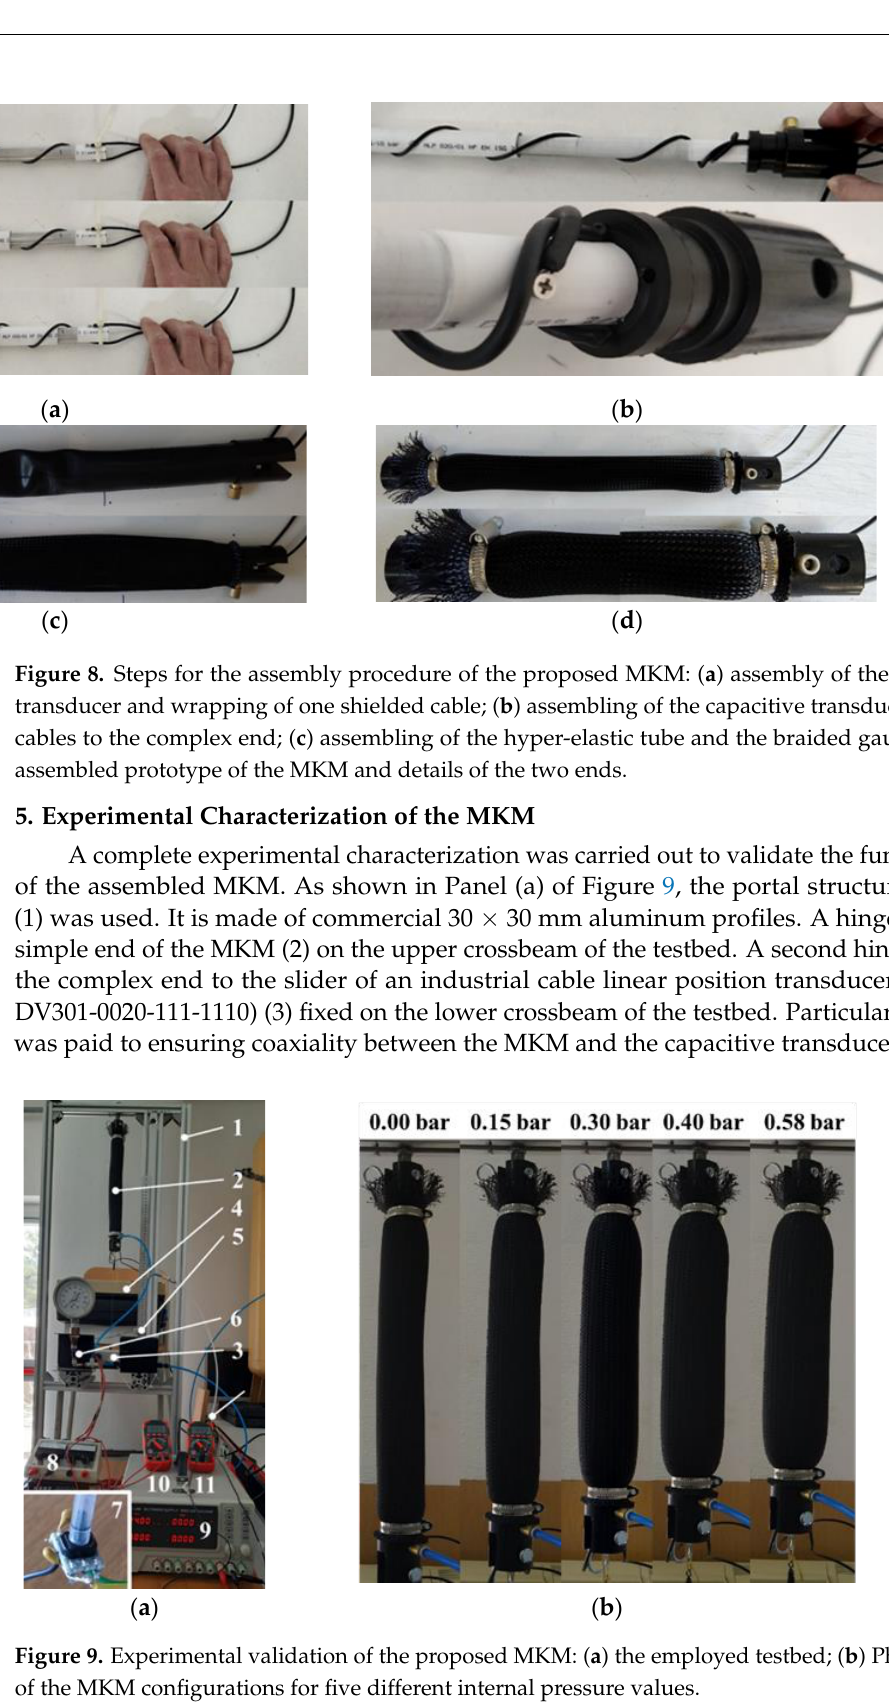
Figure 9. Experimental validation of the proposed MKM: ( a ) the employed testbed; ( b ) Photographs of the MKM configurations for five different internal pressure values.